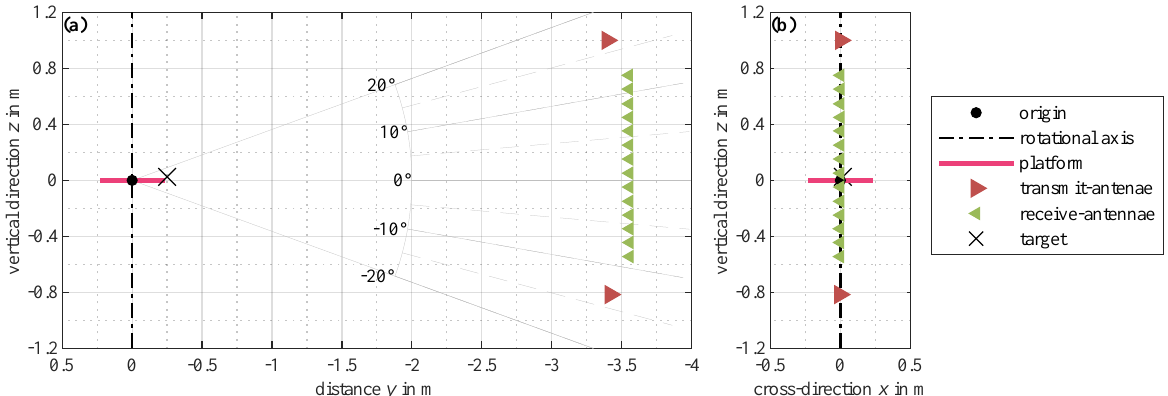
Figure 1. Illustration of the experimental setup adapted from our publication [9] with ( a ) a side-view showing the vertical arrangement of the antenna-array with an additional angular grid (note that the rotational axis of the target mounting platform is parallel to the long-axis of the array) and ( b ) a view from behind the array towards the platform. The discussed experimental results are obtained with a rotating platform and a static array in an ISAR-like measurement setup, so that the target is rotated through the arrays’ field of view. For the indicated position of the target, the geometric arrangement of the first chosen angular orientation of the platform is